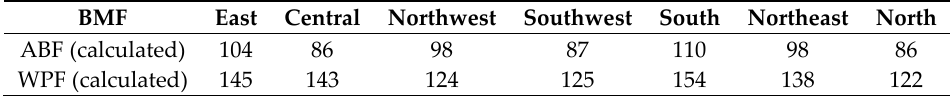
Table 7. Calculated BMF production costs in each region (USD/t). Woody pellet fuel: WPF; agricultural briquette fuel: